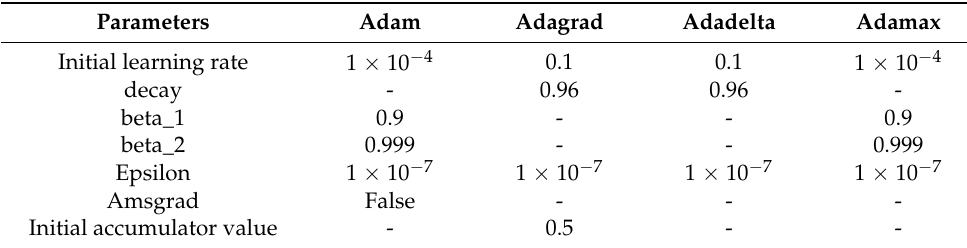
Table 1. Parameters for the different optimization algorithms.